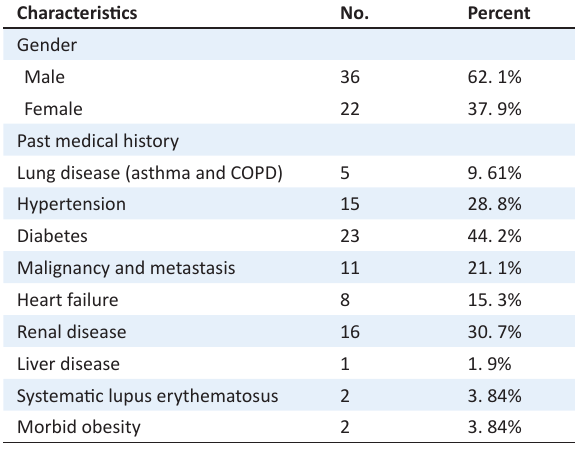
Table 1. Demographic characteristics and clinical outcomes in 58 patients undergoing CRRT